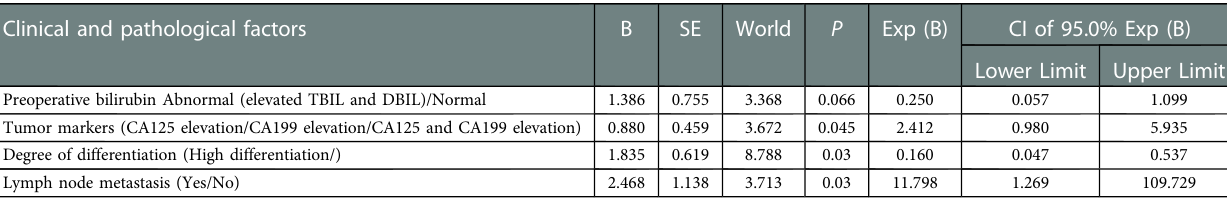
TABLE 3 Multivariate analysis of prognostic factors in patients with gallbladder cancer undergoing 2 cm hepatic wedge resection plus cholecystectomy. Clinical and pathological factors